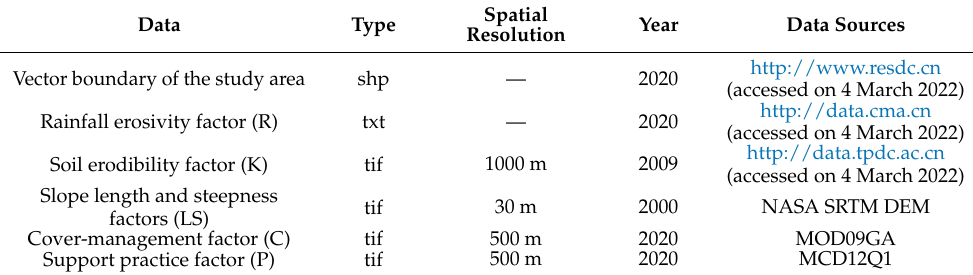
Figure 2. Land cover map of the study area. Table 1. Data